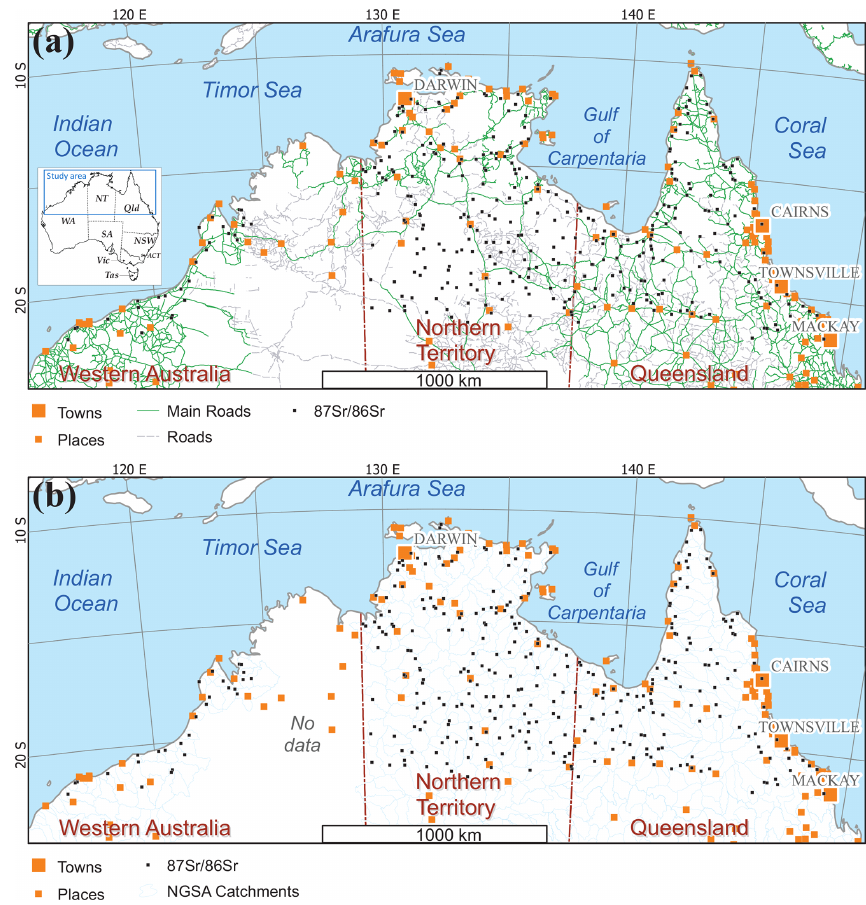
Figure 1. The northern Australia Sr isotope study area (see the inset for location: WA – Western Australia, NT – Northern Territory, Qld – Queensland, NSW – New South Wales, ACT – Australian Capital Territory, Vic – Victoria, Tas – Tasmania, and SA – South Australia) and the National Geochemical Survey of Australia (NGSA) and Northern Australia Geochemical Survey (NAGS) 87 Sr / 86 Sr sample locations (small black squares) shown with towns (large orange squares) and places (medium orange squares), main roads (solid green lines in panel a ), secondary roads (dashed grey lines in panel a ), and the NGSA catchment boundaries (medium blue lines in panel b ). Map projection: Albers equal